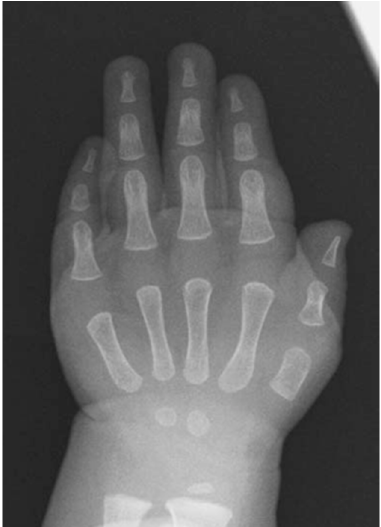
Figure6. Anteroposteriorradiographof theleft handof aFOP boyat theage of11 months demonstrating marked shortening of the first metacarpal bone. Figure 6. Anteroposterior radiograph of the left hand of a FOP boy at the age of 11 months demonstrating marked shortening of the first metacarpal bone.